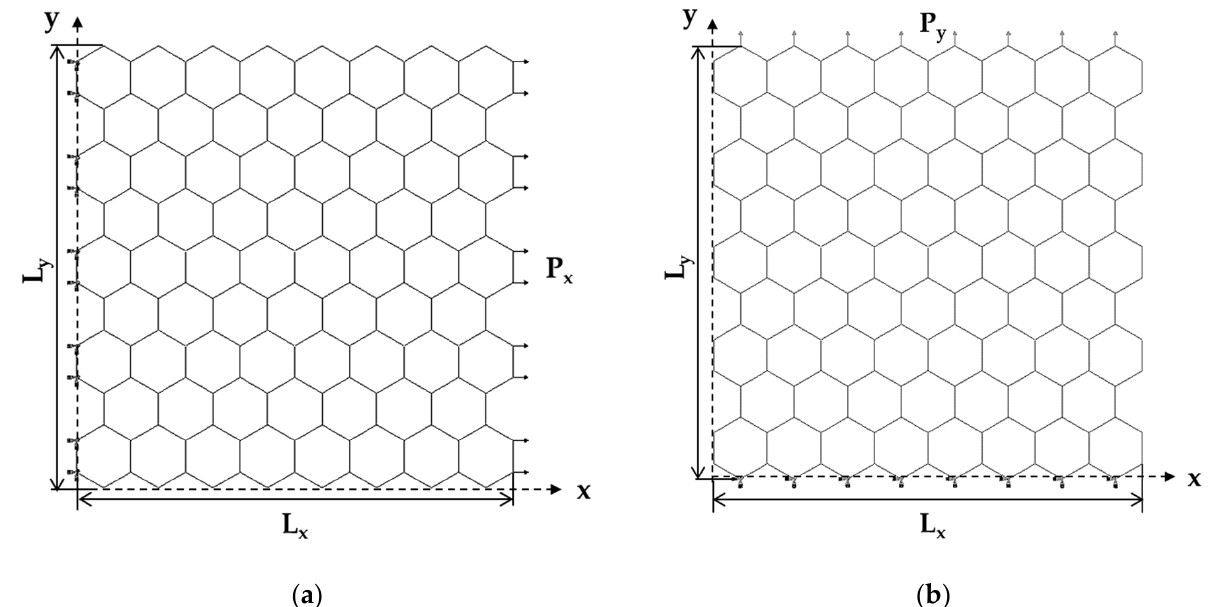
Figure 5. Boundary and loading conditions for the InNNS of size 2 (see Table 3): ( a ) horizontal tension (zigzag configuration) and ( b ) vertical tension (armchair configuration). The geometrical parameters of NS are also shown.